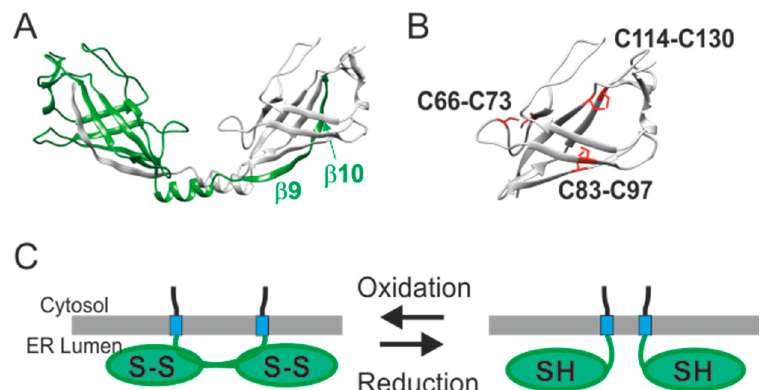
Figure 3. Structure and putative redox-dependent rearrangement of the SARAF luminal fold. ( A ) Structure of the SARAF domain-swapped dimer (PDB ID: 6O2U). Chains A and B are shown in green and grey, respectively, and the 9th and 10th β -strands from chain A are also labeled. ( B ) Magnification of the structure of b1 to b8 from chain A with cysteine residues forming disulfide bonds highlighted in red. ( C ) Cartoon representation of the SARAF luminal fold showing putative dimer to monomer reversible transitions mediated by oxidation-reduction of cysteine pairs indicated in ( B ). S–S denotes disulfide bonds.